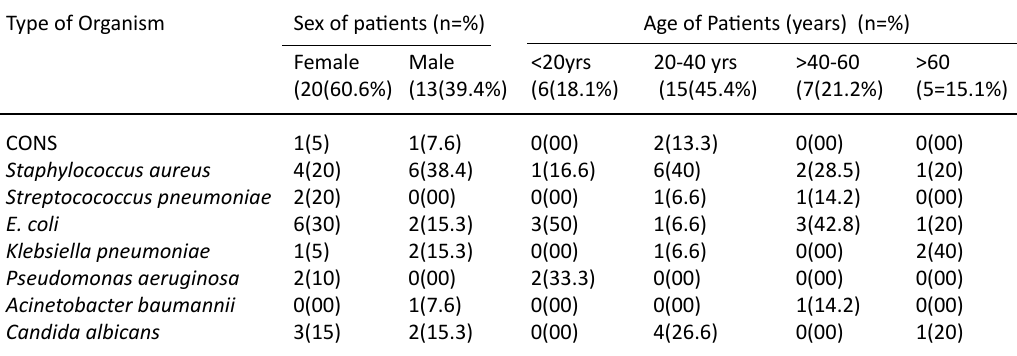
Table 4. Distribution of Organism according to the Sex & Age of the Tribal patients Type of